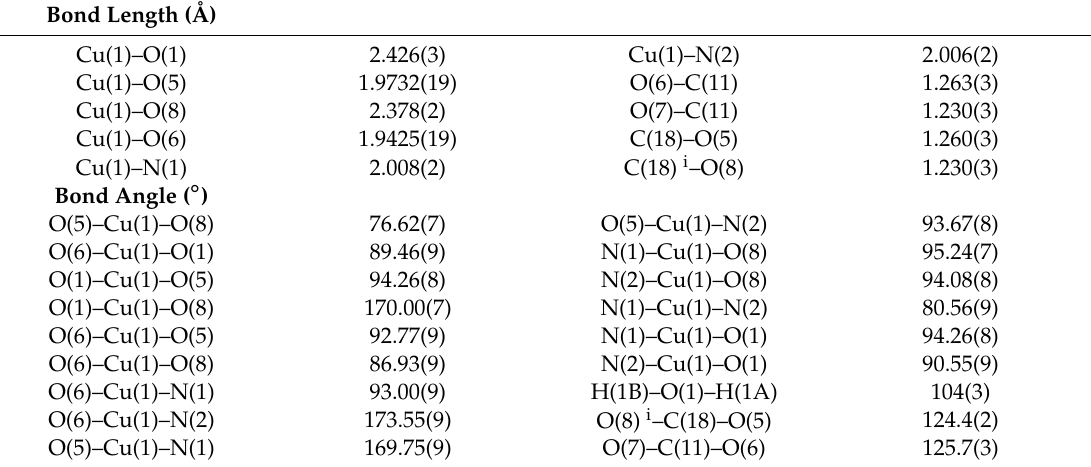
Table 1. Selected bond lengths (Å) and angles ( ◦ ) for 1 , with estimated standard deviations in